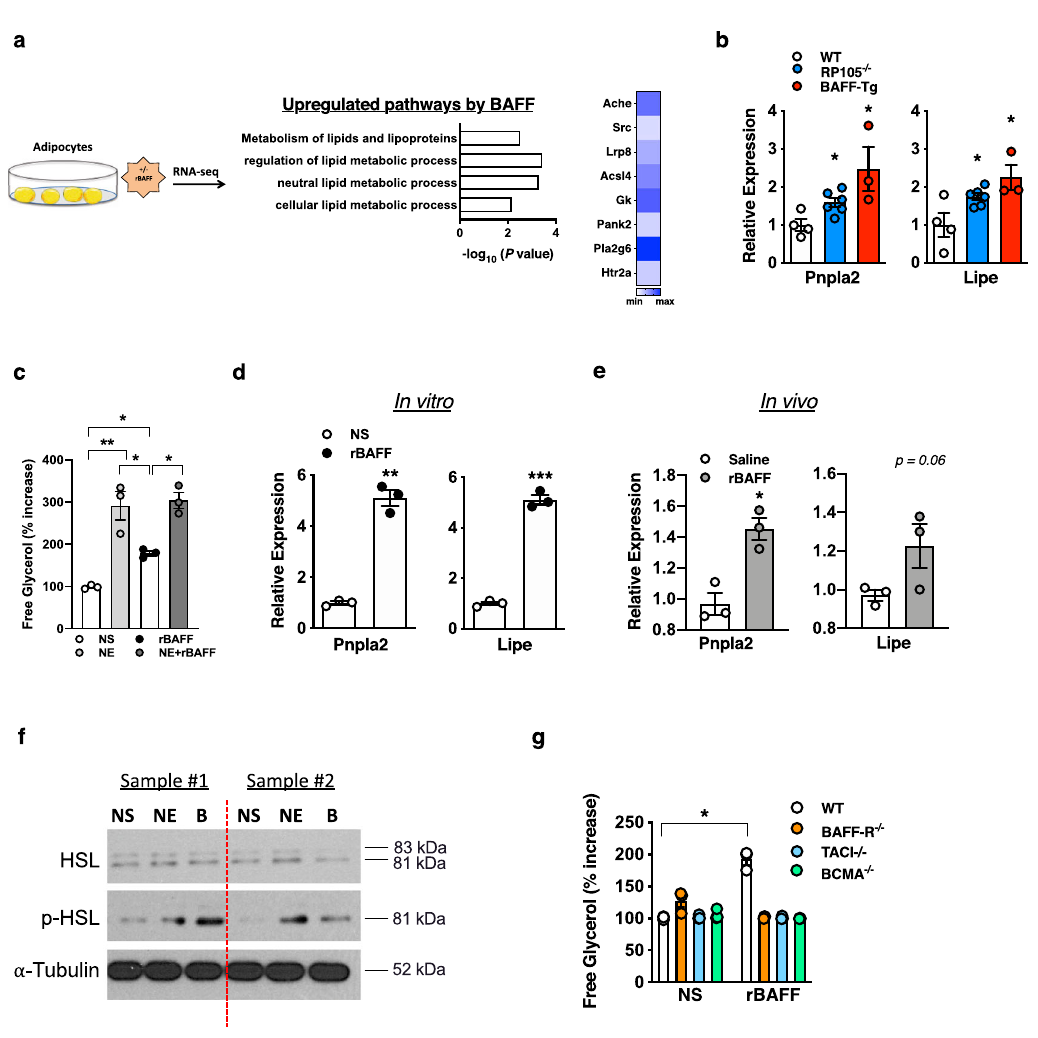
Fig. 2 BAFF modi fi es white adipose lipid handling. a White adipocytes stimulated in the presence or absence of recombinant BAFF (rBAFF; 500 ng/ml) and subjected to RNA-seq analysis. Ontology pathways and heat map of selected associated genes. b eWAT mRNA expression quanti fi ed by qPCR of indicated lipolysis genes in WT, RP105 − / − or BAFF-Tg mice after 20 weeks on a HFD. c – d White adipocytes treated with saline (NS), norepinephrine (1 µ M), or rBAFF (500 ng/ml) for 24 hours. c Free glycerol. % increase relative to WT NS. d mRNA expression of indicated lipolysis genes. e CD-fed WT mice were treated i.p. with rBAFF (2 μ g/mouse) every other day for 1 week. eWAT mRNA expression of indicated lipolysis genes. f Primary white adipocytes from WT mice were treated with saline (NS), norepinephrine (NE; 1 µ M), or rBAFF ( b 500 ng/ml) for 12 hours. Protein expression of hormone- sensitive lipase (HSL), phosphorlayted HSL (p-HSL), and α -tubulin loading control by western blot. g Free glycerol in supernatants of WT, BAFF-R − / − , TACI − / − , or BCMA − / − adipocytes treated with saline (NS) or rBAFF (500 ng/ml). % increase relative to WT NS. a A single experiment, n = 2/condition. b Representative of three independent experiments, n = 3 – 6/condition. c – d Representative of three independent experiments, n = 3 – 6/condition. e Representative of two independent experiments, n = 3/condition. f Representative samples of a single experiment, n = 3. g Representative of two independent experiments, n = 3/condition. b – e , g For bar graphs, data represents mean±SEM. b – e , g Unpaired two-tailed Student ’ s t test. * p < 0.05, ** p < 0.01, *** p < 0.001. Source data are provided as a Source data fi